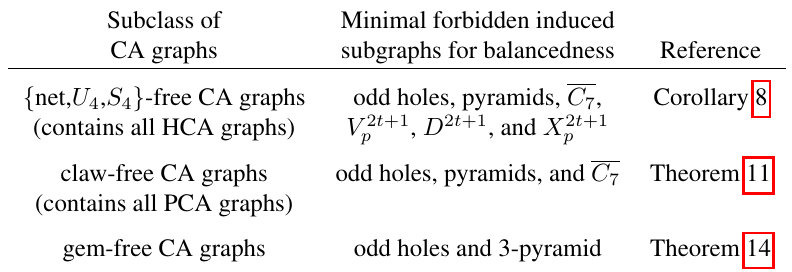
Tab. 1: Minimal forbidden induced subgraphs for balancedness in each studied subclass of CA graphs Subclass of Minimal forbidden induced CA graphs subgraphs for balancedness Reference { net, U 4 , S 4 } -free CA graphs odd holes, pyramids, C 7 , Corollary 8 (contains all HCA graphs) V 2 t +1 , D 2 t +1 , and X 2 t +1 p p claw-free CA graphs odd holes, pyramids, and C 7 Theorem 11 (contains all PCA graphs) gem-free CA graphs odd holes and 3-pyramid Theorem